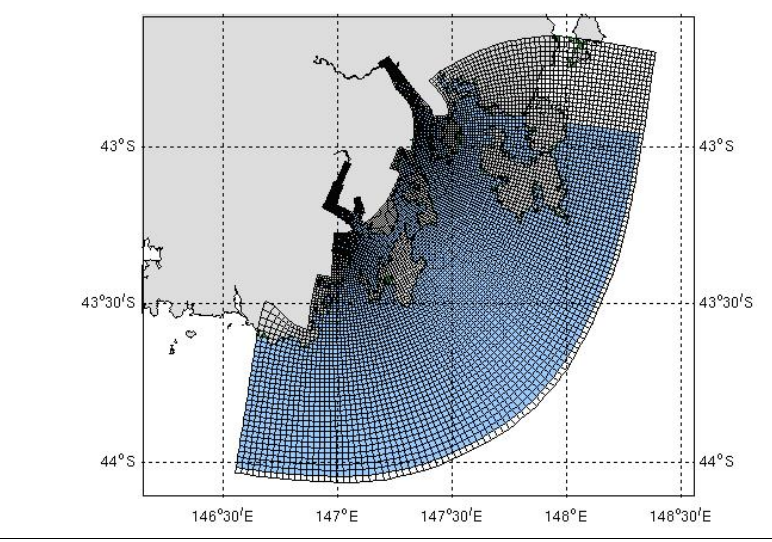
Figure 5. Model grid (South East Tasmania,